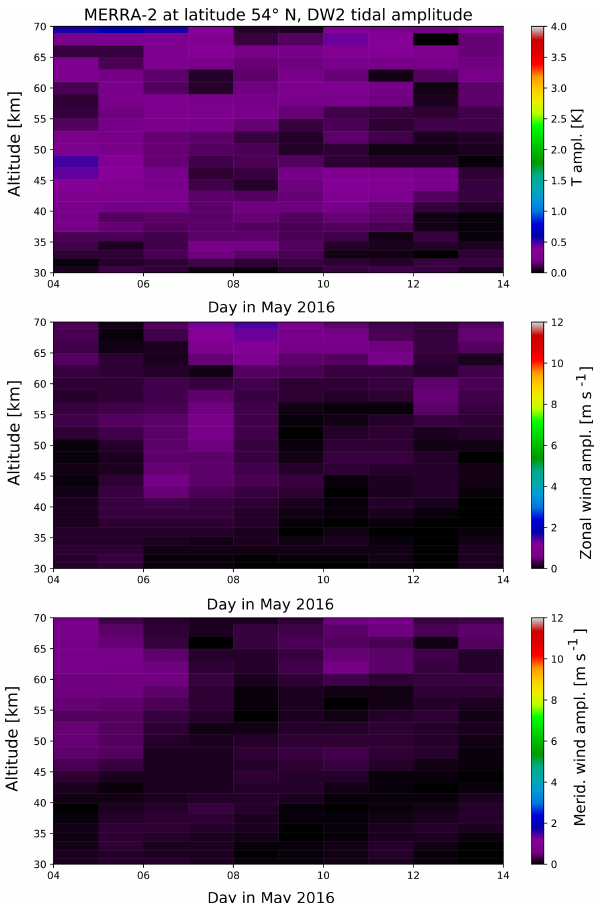
Figure A4. DW3 amplitude in temperature, zonal and meridional wind from global MERRA-2 fields at the latitude of 54 ◦